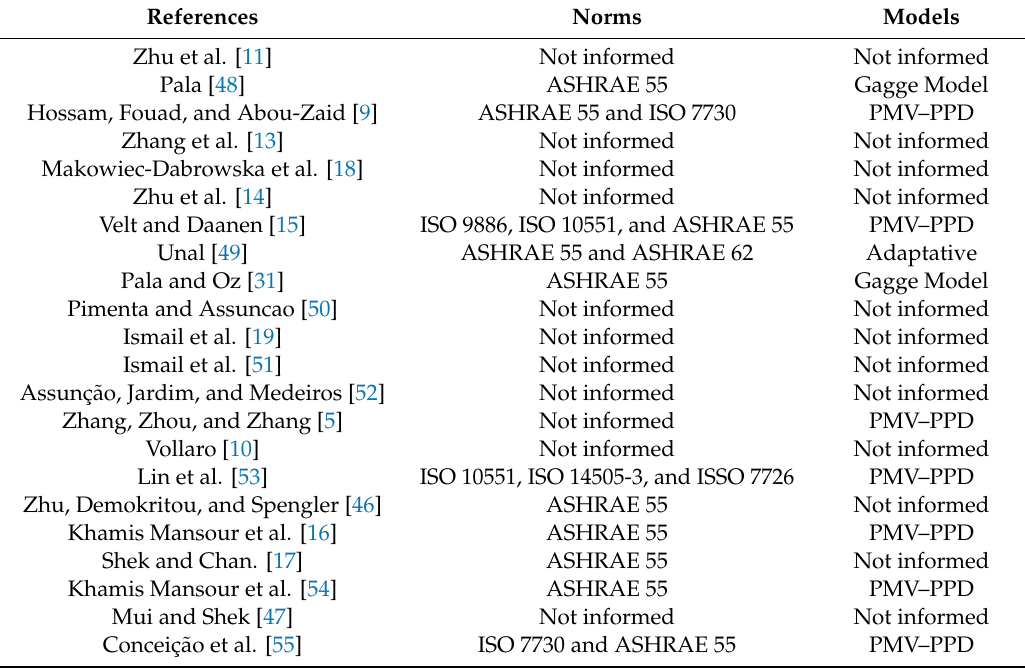
Table 10. Standards and models employed in thermal comfort studies in bus